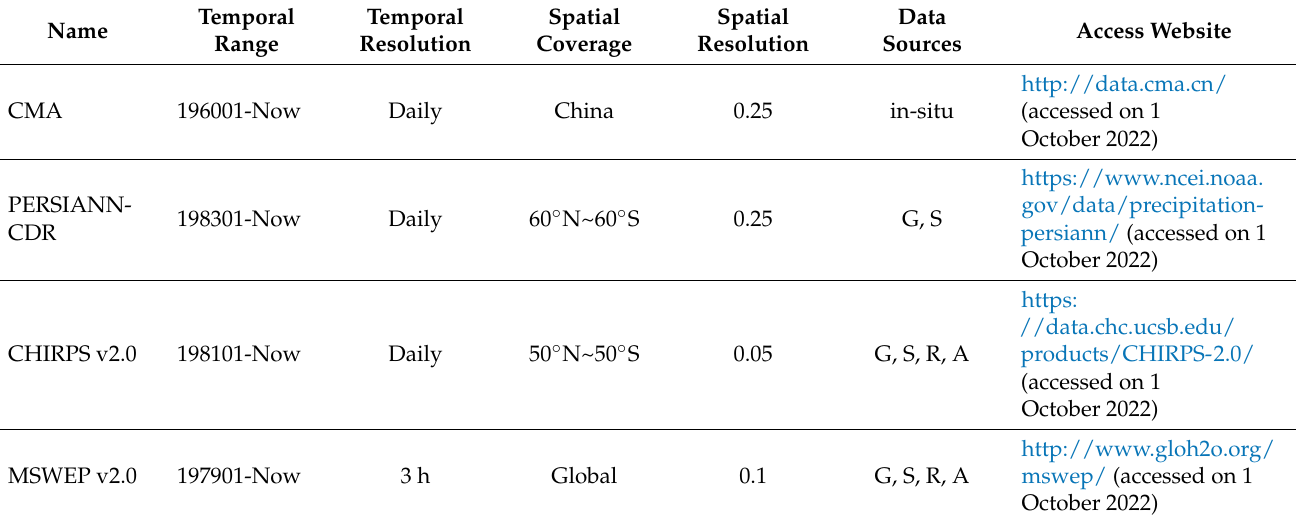
Table 1. Basic information of precipitation